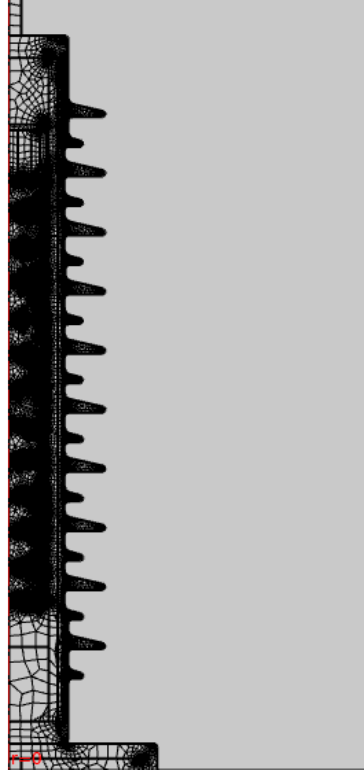
Figure 12. Meshing of the Simulation Model.